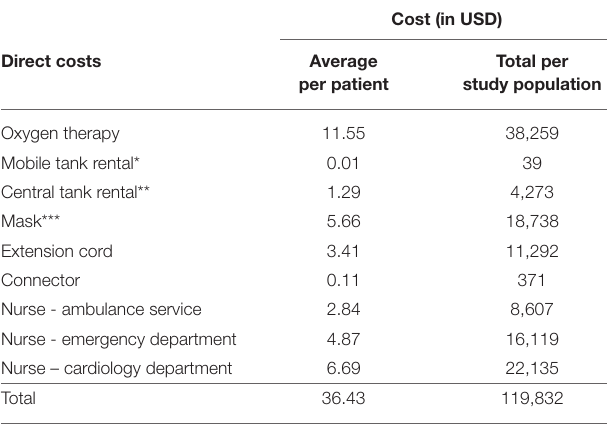
TABLE 2 | Total calculated cost related to oxygen therapy including cost of a drug, medical supplies, and staff per patient and care episode for patients with suspected MI.